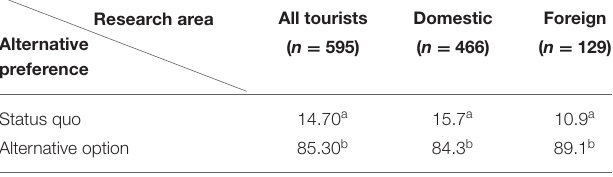
TABLE 3 | Tourists’ preference to establish an impact mitigation program.